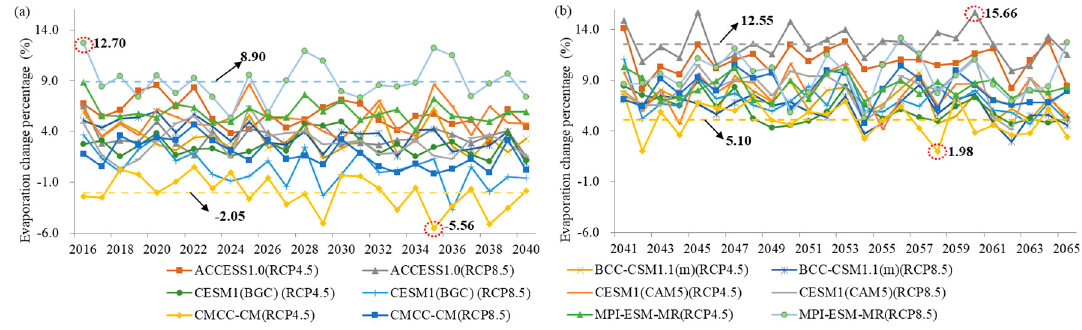
Figure 12. The forecasted evaporation change percentage relative to 1980–2004 period under CMIP5: